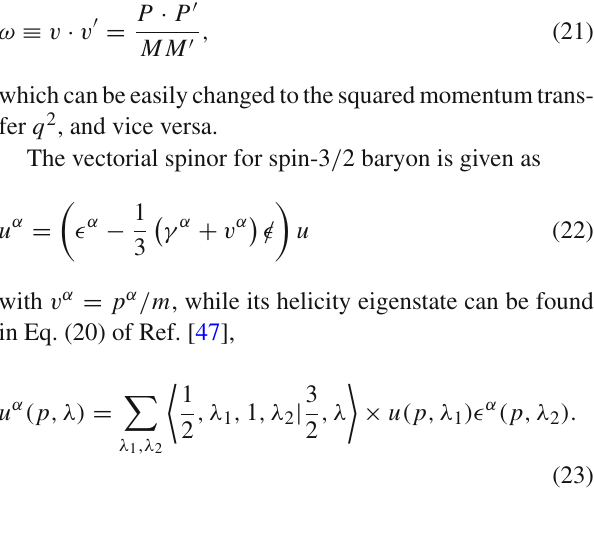
is defined with cq ( q = u , d , s ) as a scalar or an axial-vector diquark